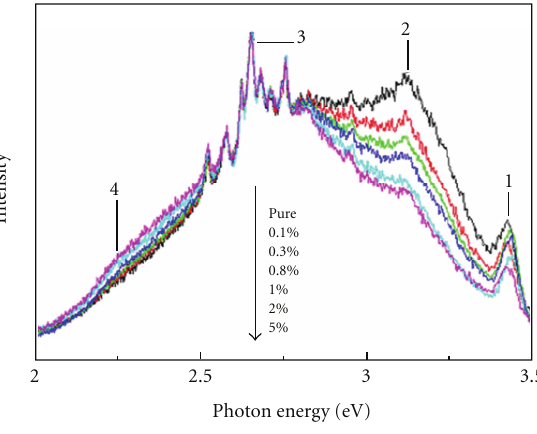
Figure 5: The PL spectra Fe-doped TiO 2 nano